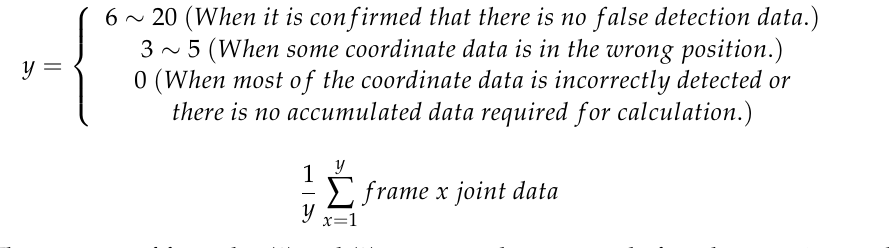
Figure 8. A flowchart of a method of stabilizing data when detecting an object.